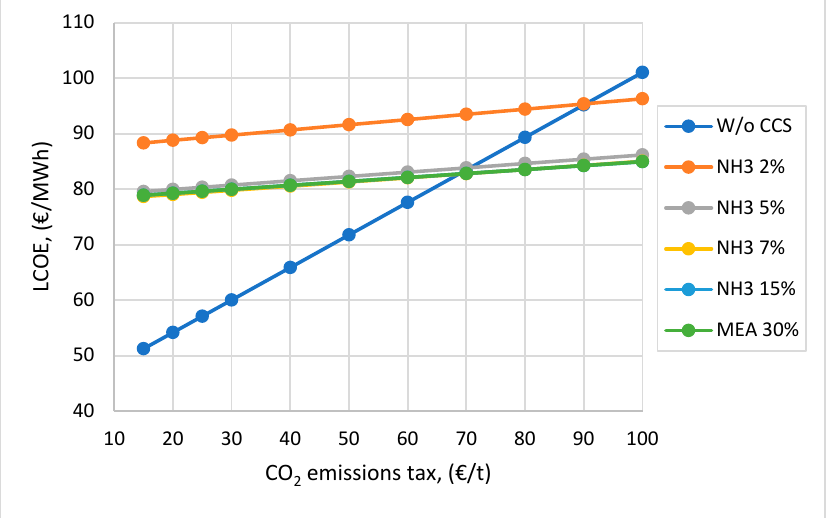
Figure 4. The LCOE with and without a CO 2 capture process according to the CO 2 emissions tax.